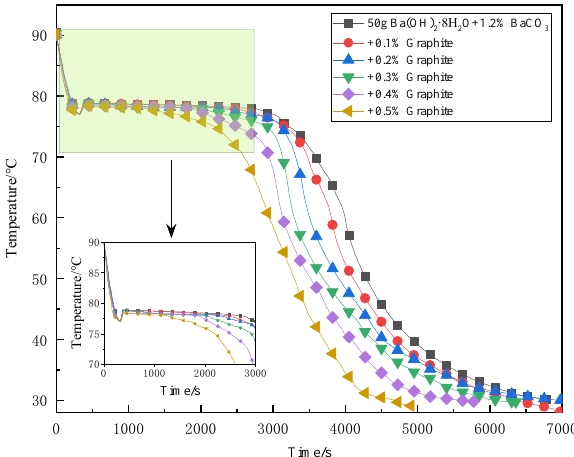
Figure 5. Supercooling curve diagram of graphite powder with different mass fractions.